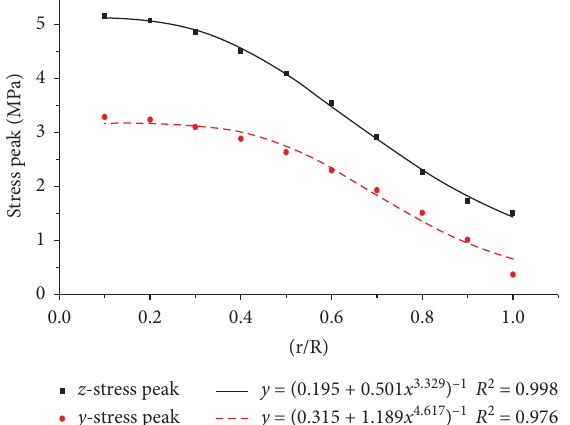
Figure 18: Distribution of the axial and radial stress peaks.